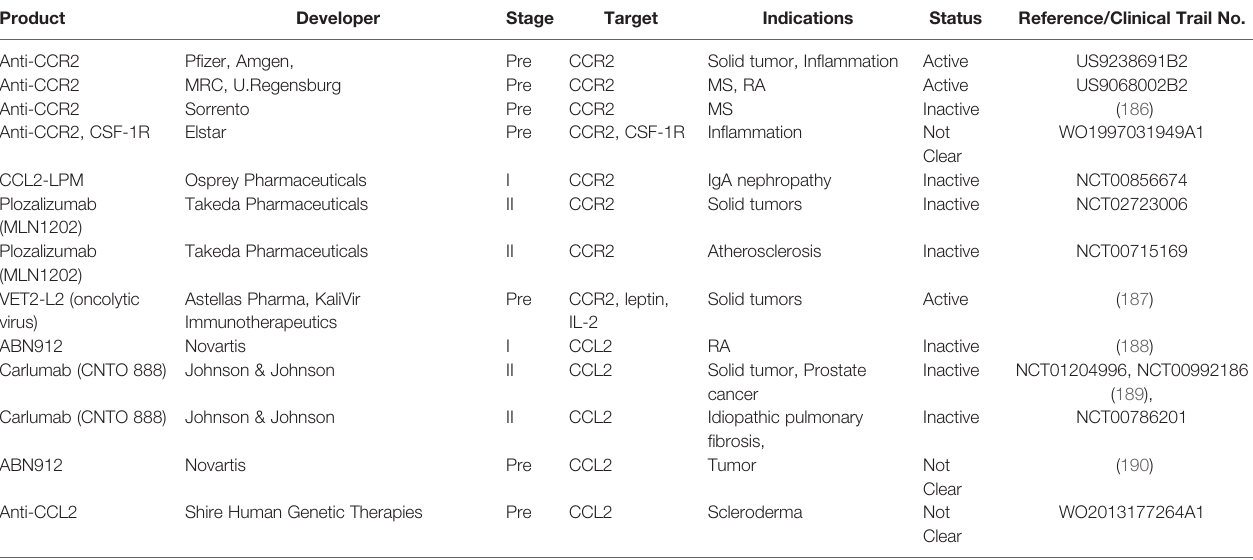
TABLE 3 | Antibodies targeting CCR2-CCL2